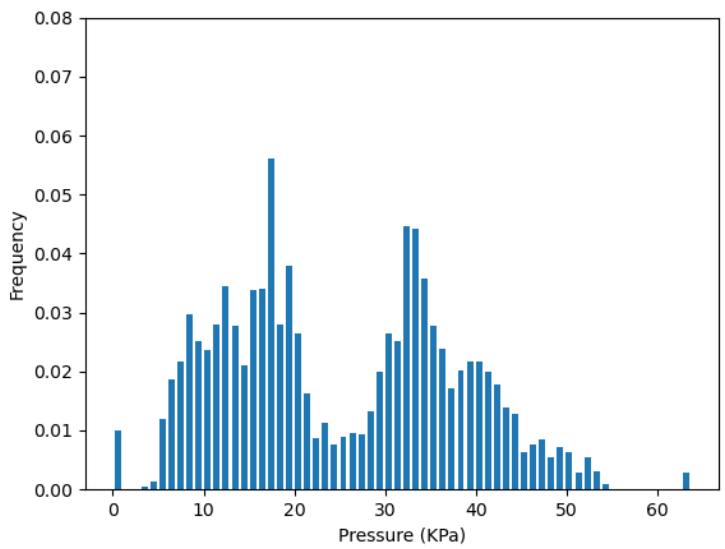
Figure 13. Pressure distribution from all sensors in C l